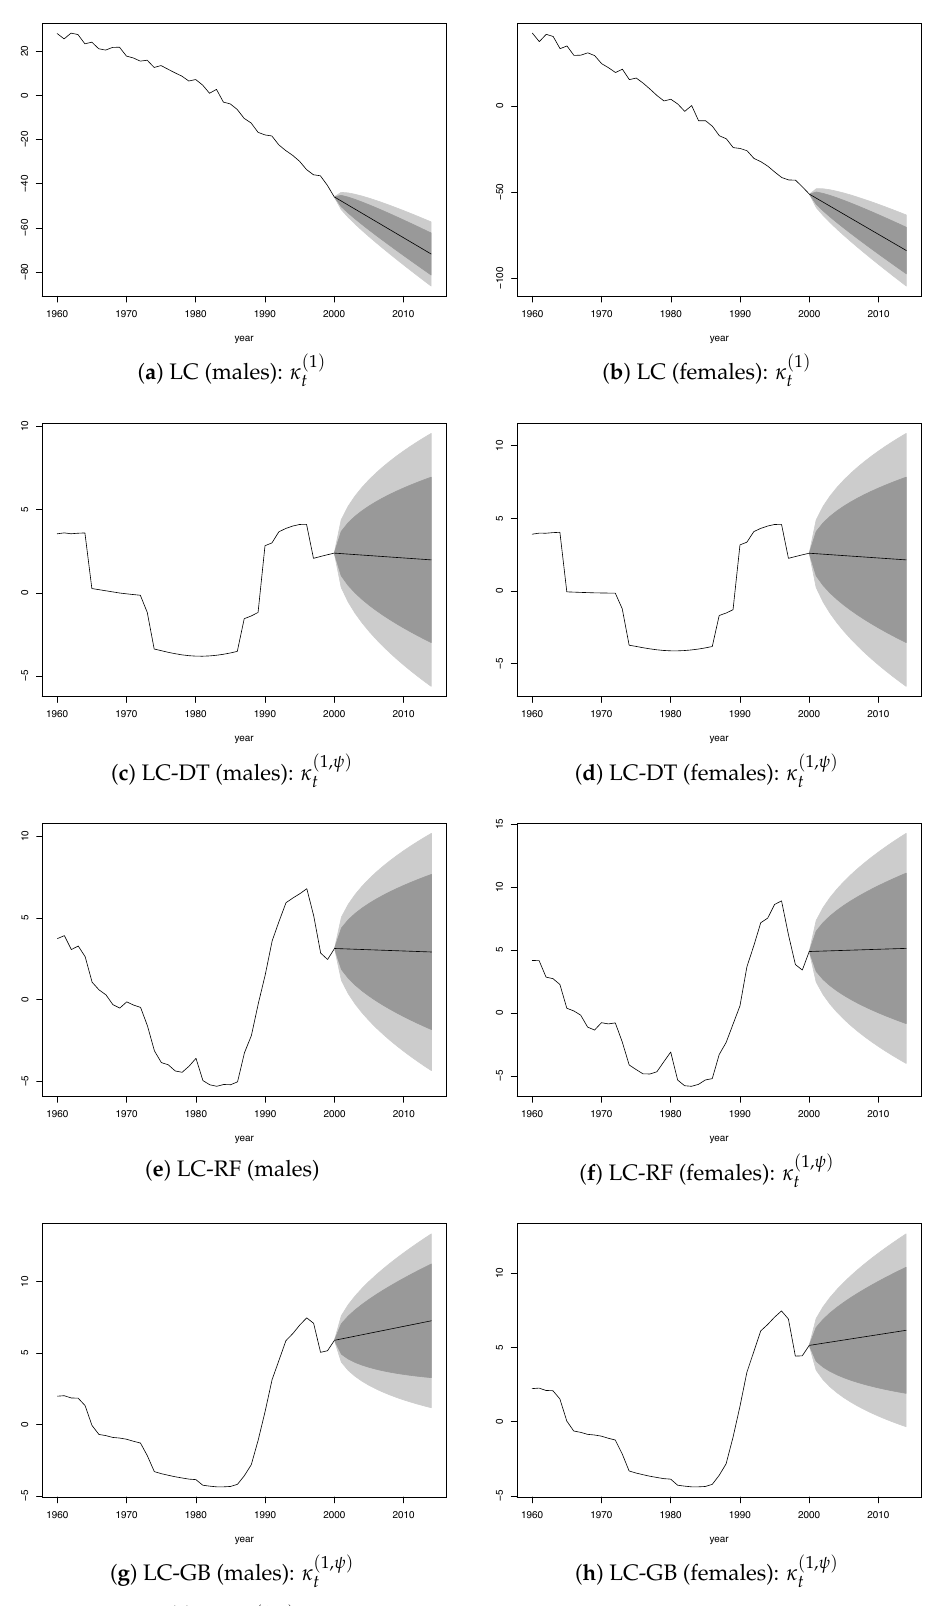
( 1, ψ ) ( 1 ) and κ : Fitted value (1960–2000) and forecasted values t t